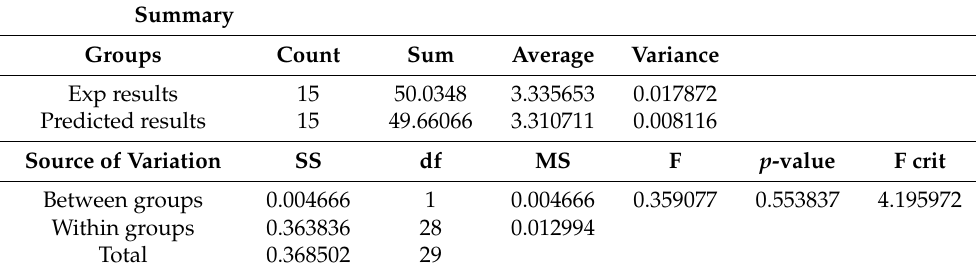
Figure 11. Scheffe’s model results vs. experimental control points for flexural strength. Table 9. ANOVA test results.